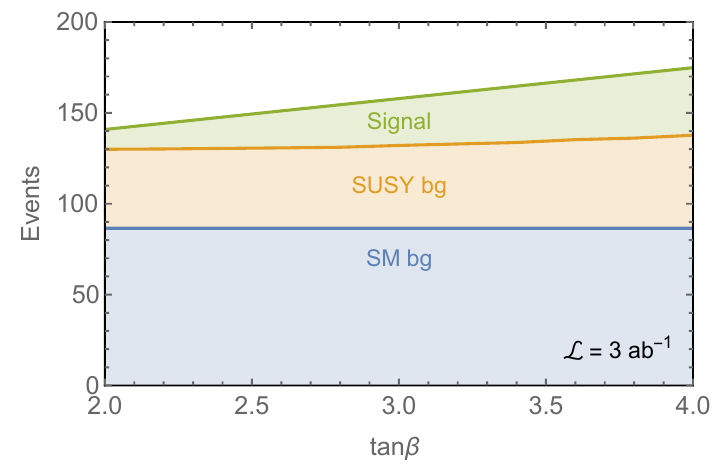
Figure 11 . Stacked number of events passing our cuts at 3 ab (cid:0) 1 for the signal and background for di(cid:11)erent values of tan (cid:12) . We de(cid:12)ne the signal as (~ (cid:31) 0 cascades are considered to be a part of the SUSY background. The SM background mainly consists of ZZZ production. We use NLO production cross sections for the signal (Prospino 2 [40]) and background